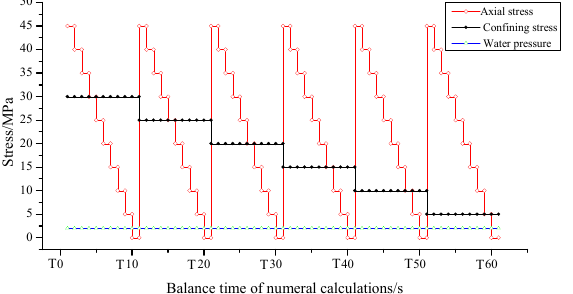
Figure 13. Stress path of the seepage experiment.